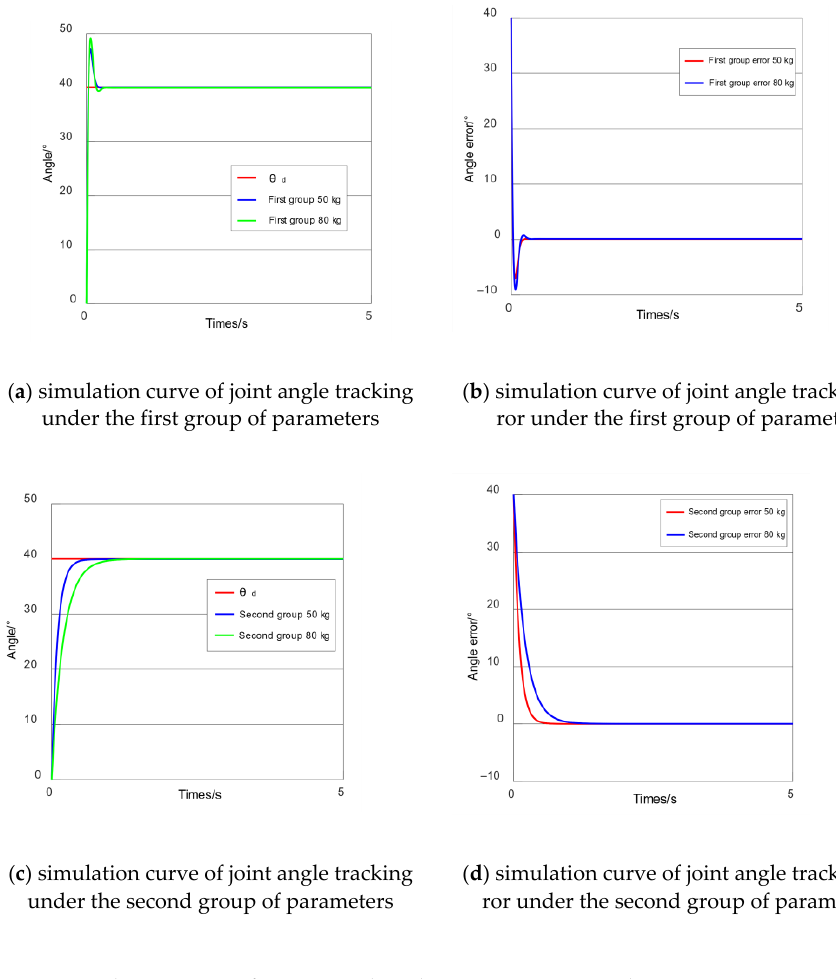
Figure 4. Simulation curve of PID control tracking step input